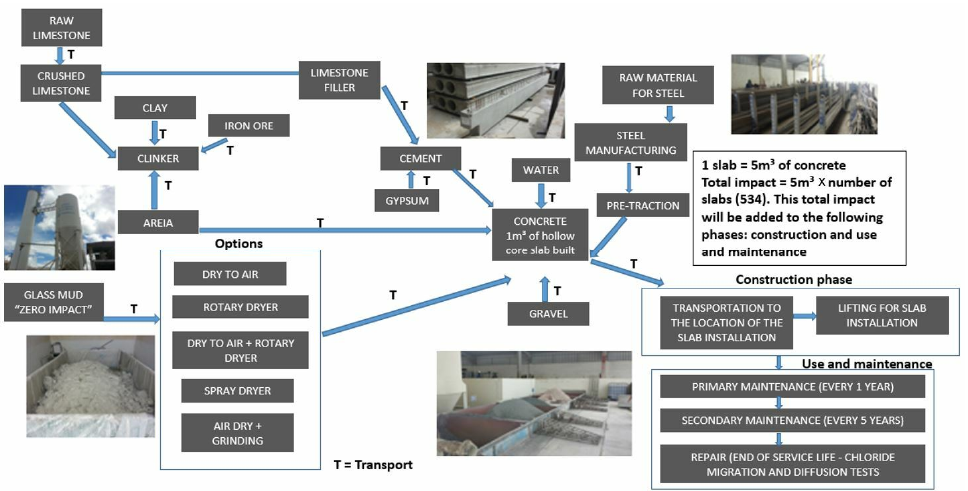
Figure 10. Life Cycle Assessment boundaries.